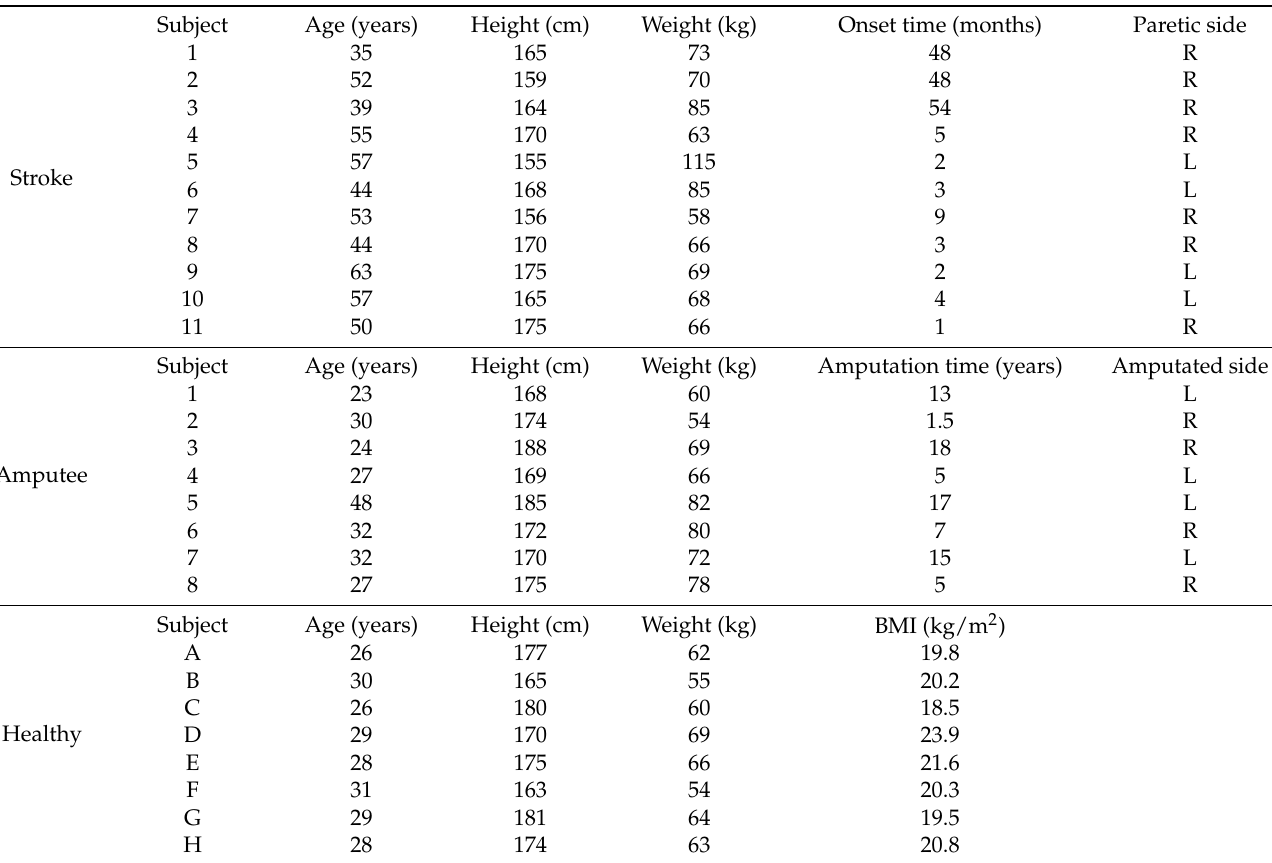
Table 1. Subject information of stroke, amputee, and healthy